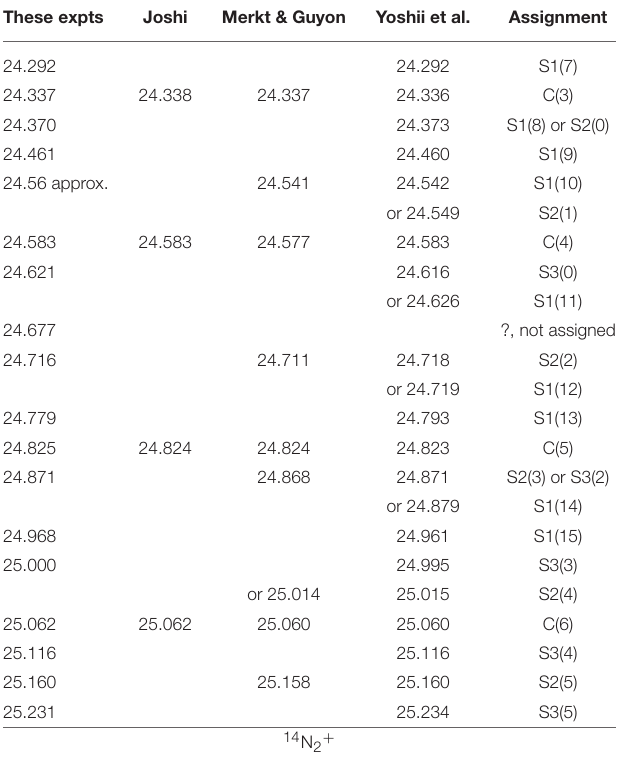
TABLE 1 | Spectral features observed in the TPEPICO spectrum of 14 N 2 between 24.2 and 25.24eV ( Figure 1 ). These expts